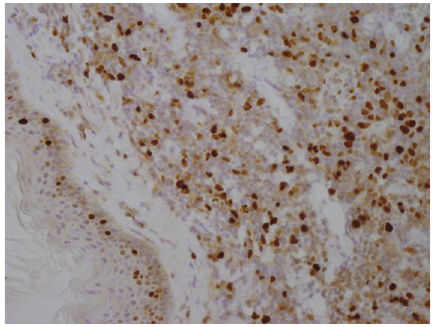
Figure3:PositivecyclinD1nuclearimmunoreactivityinlymphoma cells (40x).